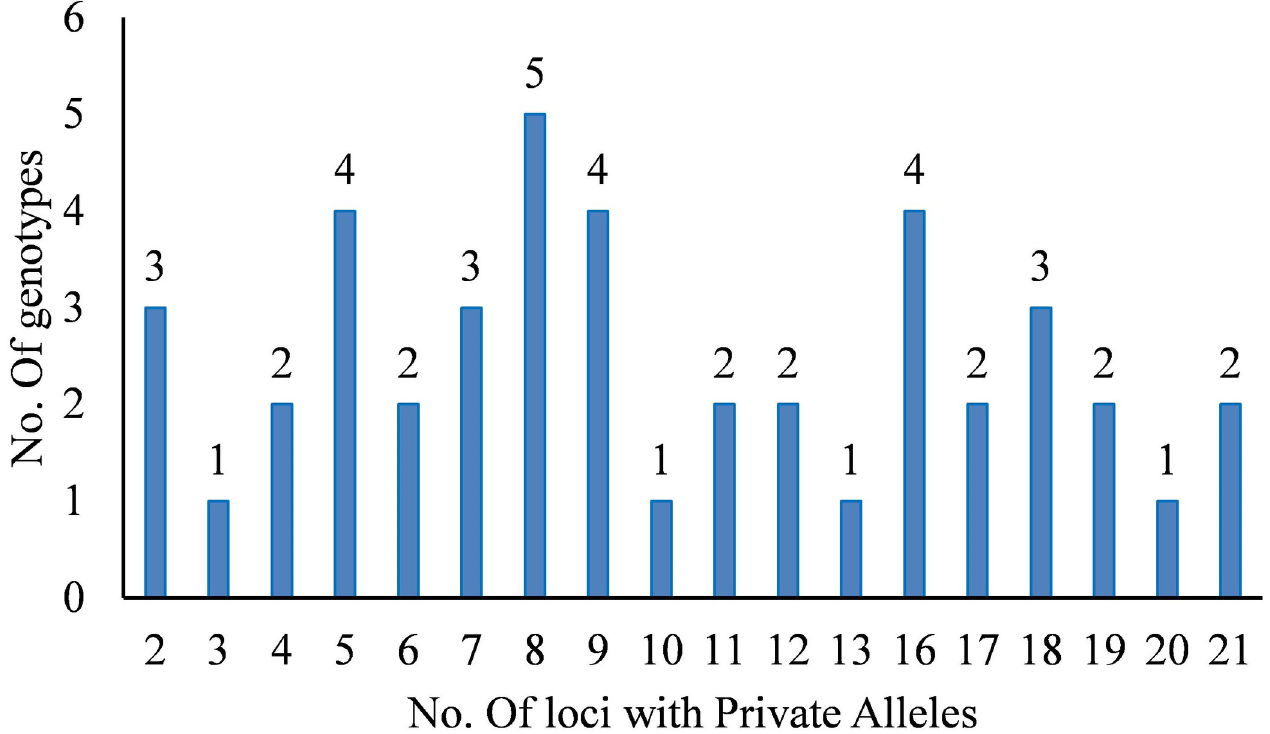
Fig 5. Variation of number of genotypes with private alleles within all the 44 pigeonpea analyzed genotypes.